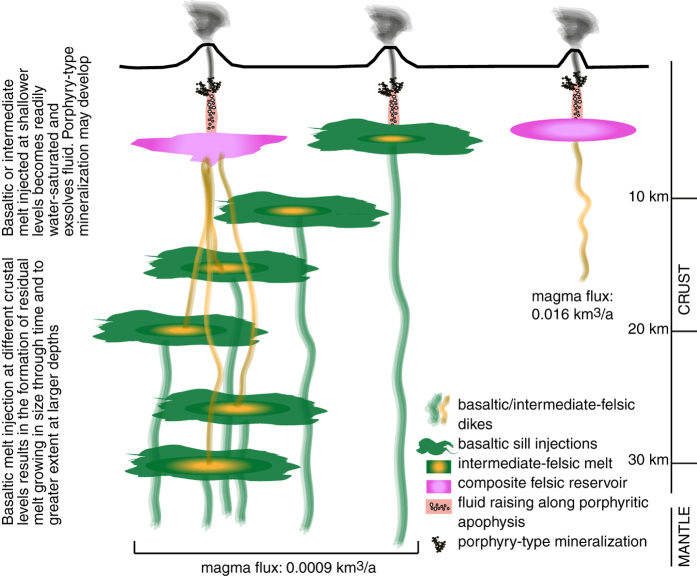
Conceptual model of intermediate-felsic melt generation in the arc crust (modified after ref. 16).In the arc environment intermediate/felsic melts form as a consequence of injection of basaltic sills at different crustal depths. They result from residual melts issued from the fractionation of the injected basalt that eventually mix with partial melts of the host rocks, forming a hybrid melt. Because of thermal constraints hybrid melts generated at greater depths can grow in size much more than hybrid melts formed at shallower depths after a given time since the onset of basaltic sill injection. Hybrid melts formed at deeper crustal levels are H2O-undersaturated and must rise to shallower crustal levels to be able to exsolve fluid and form porphyry deposits. Intermediate-felsic magmatic systems generated by basaltic melts injected at shallow crustal levels under average magma fluxes may exsolve fluid readily but are generally limited in volume. Intermediate-felsic magmas injected at shallower levels under high magma fluxes result in the transient construction of large magmatic reservoirs that may readily exsolve fluids and could form porphyry deposits. However, the size of these potential deposits is limited by the duration of the high magmatic flux (<~200 ka)2026.